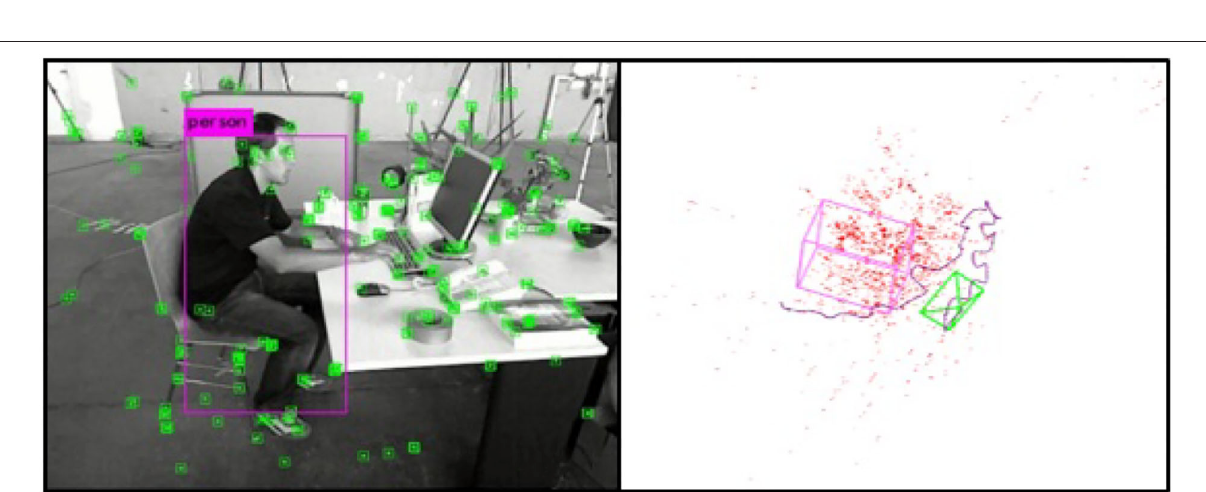
Frontiers in Neurorobotics |